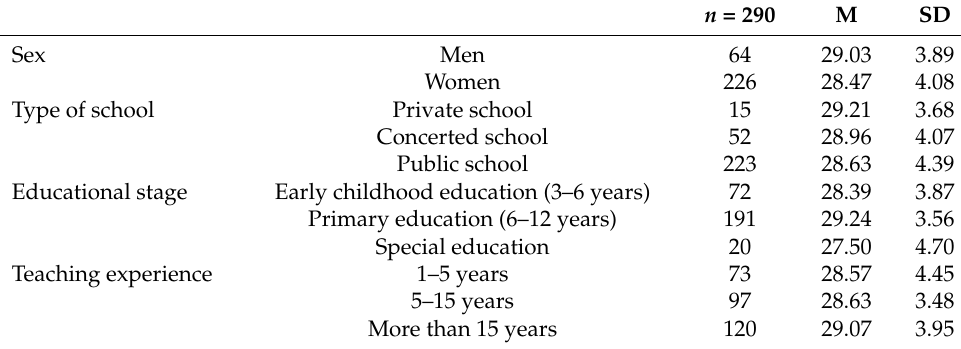
Table 6. Resilience level of teachers according to demographic